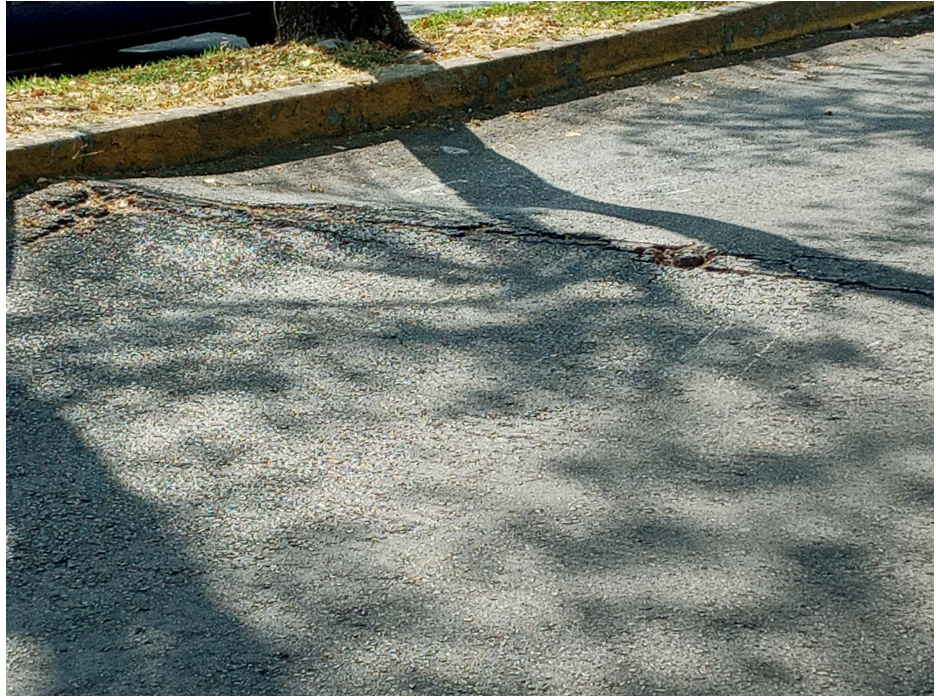
Figure 3. Somewhere in Mexico City. This is an example where a pothole turns into a “speed hump” caused by tree roots. Observe the sinking/uplift